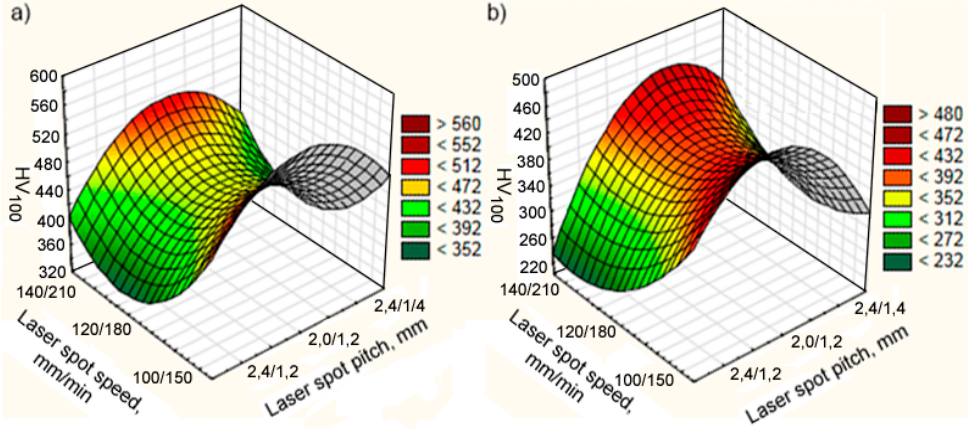
Figure 20. The effect of laser spot speed and pitch on the microhardness of the components of a double composite layer: ( a ) 12N-01 alloy; ( b ) Fe–Al composite layer.